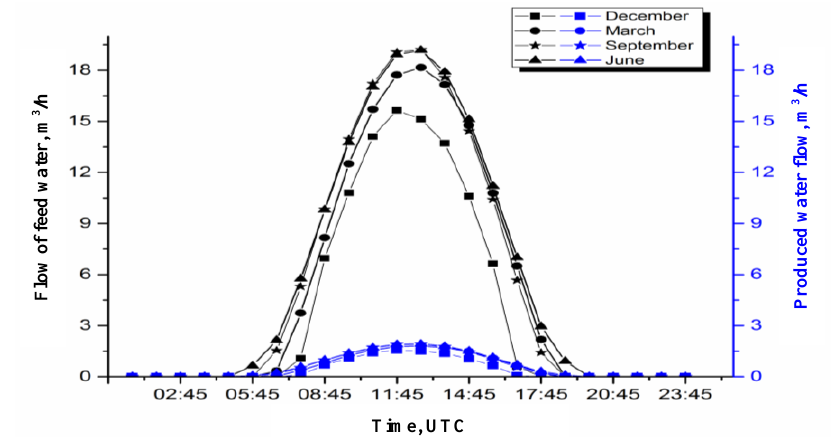
Fig. 5. Flow rate of feed water and produced water flow for a C a = 2 g/l concentration and a conversion rate y = 10 % in Casablanca. Water and energy are two key elements of sustainable development and they must be recognized as such. Water supply and energy supply are intimately linked. Decisions made in one area affect the other. Increase in the feed rate results in a decrease in the conversion rate, but, at the same time, it increases the production rate. Therefore, it can be said that high feed rates lead to high mass transfer coefficients. Fig. 5 represents, respectively, the feed water flow and fresh water flow rates produced: for a concentration C a = 2 g/l and a conversion rate y = 10 %, the maximum flow rates of the feed water. Fresh water in December produced 15.6 m 3 /h and 1.5 m 3 /h, and the production for this month is 9.5 m 3 /day. The concentration of feed water, that is, brackish water, effects feed water and freshwater flows.